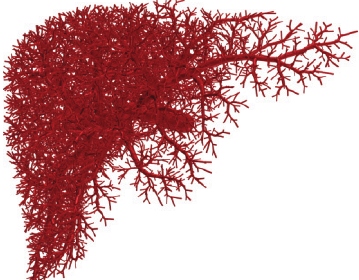
Figure 5: This vascular tree was generated applying the CCO algorithm including angle postprocessing to extend the clinical PV data set from Figure 4 without first pruning it. Each of the 10 000 leaf nodes in this setting is meant to supply about 125 lobules in the corresponding human